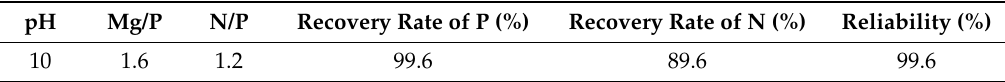
Table 5. The ratios of the optimized scheme. Table 5 The ratios of the optimized scheme.